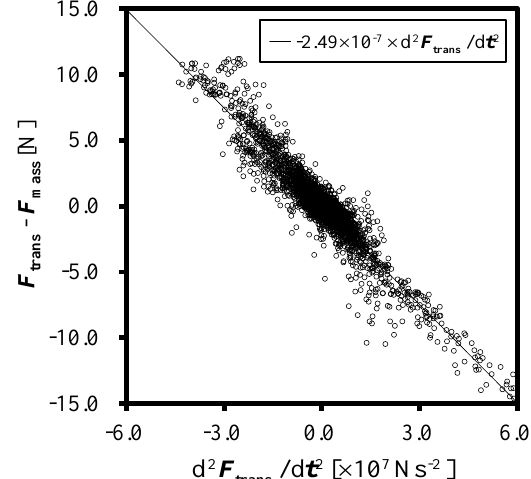
and F trans mass